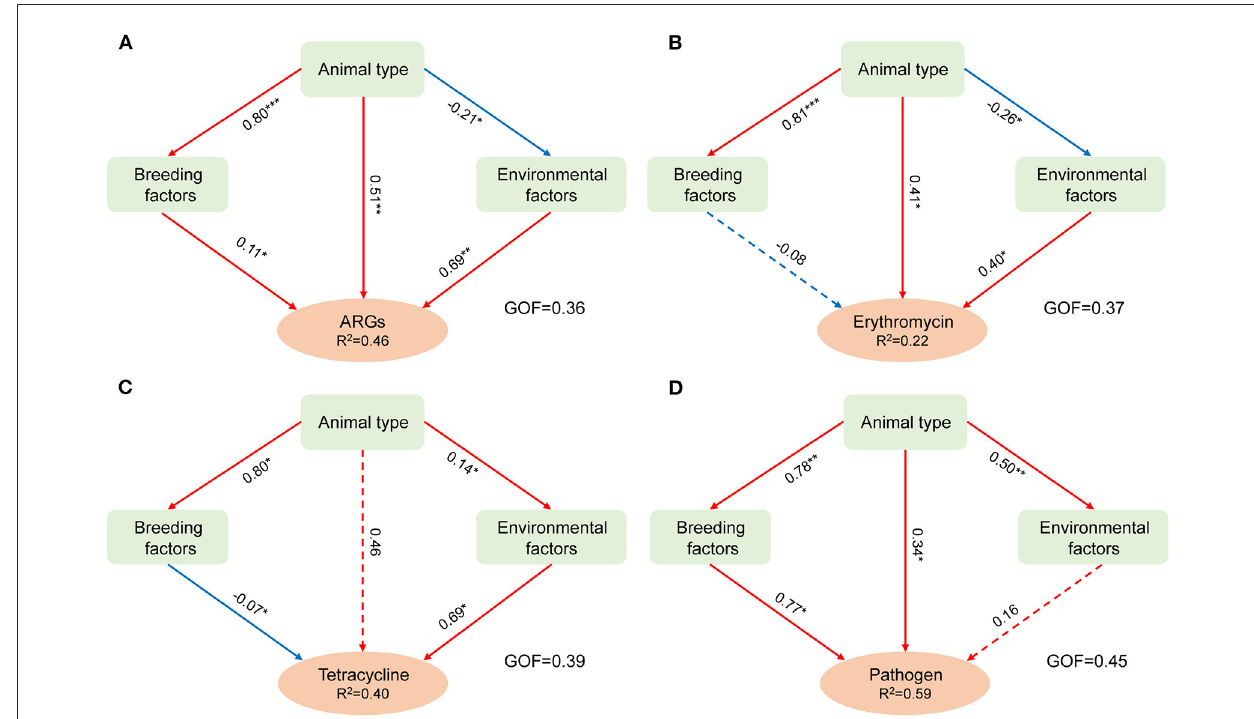
FIGURE5 Main factors influencing the aerosolization behavior of antibiotic-resistance genes (A) , erythromycin-resistant bacterial genera (B) , tetracycline-resistant bacterial genera (C) , and human pathogenic bacteria (D) using partial least square path modeling (PLS-PM). The red and blue arrows represented the positive and negative effects, respectively. The dotted and solid lines indicated significance (* p ≤ 0.05, ** p ≤ 0.01, *** p ≤ 0.001). GOF indicated the overall measure of model fit (Henseler and Sarstedt,